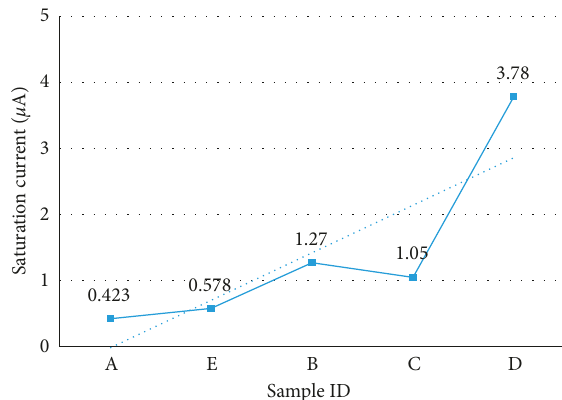
Figure 9: PF emission saturation currents of failed samples as sorted by time-to-failure in ascending order for 35 V 22 μ F chip tantalum capacitors after 1.6xVr at 85 ° C for 100,000